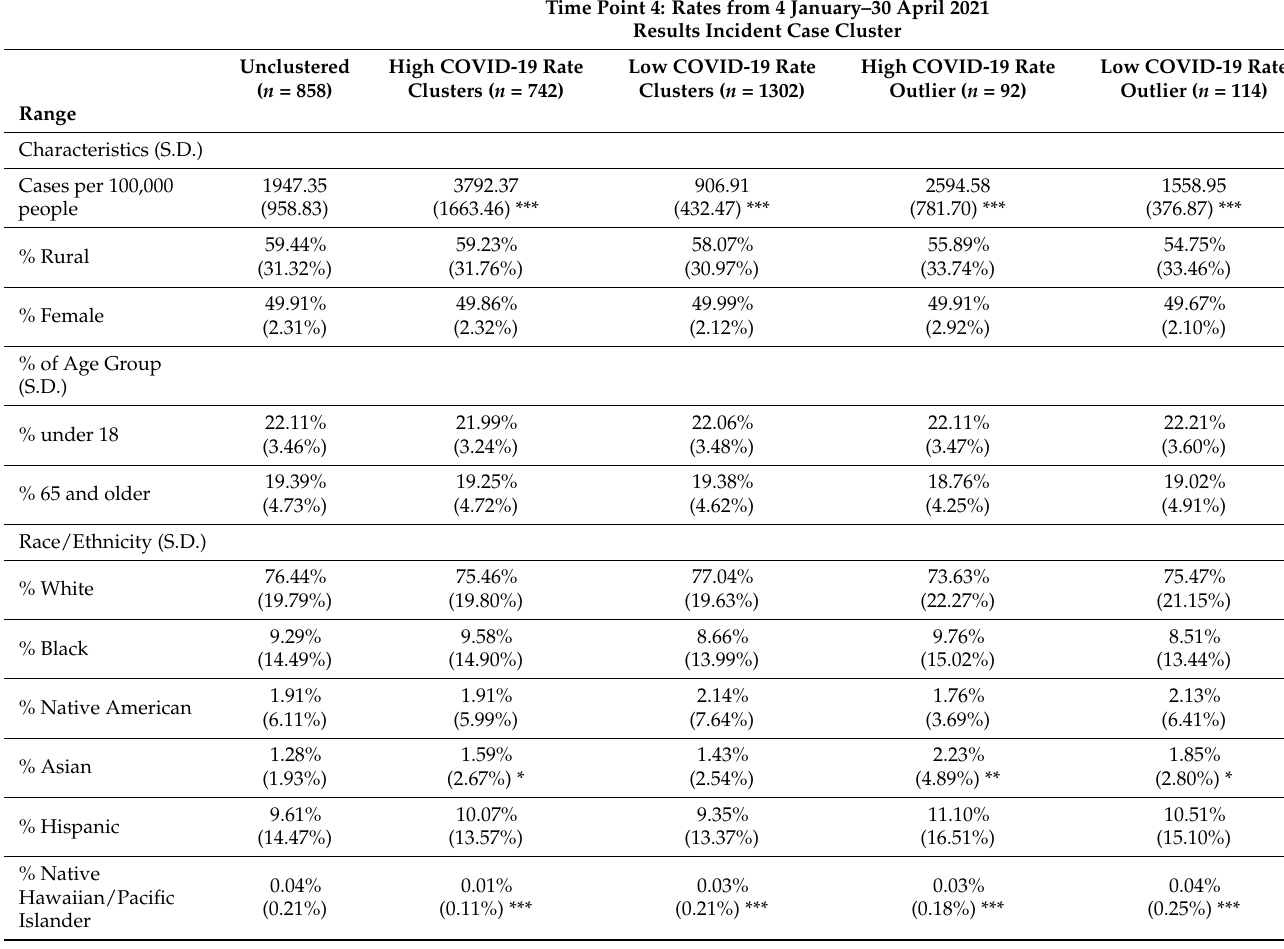
Table 4. County characteristics based on Anselin Moran’s I results for Time Point